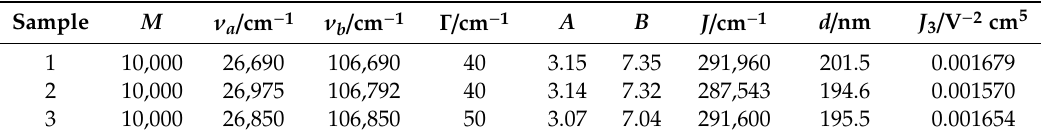
Table 4. Here, beta-distributed oscillator (ß_do) parameters of all samples obtained from the spectra